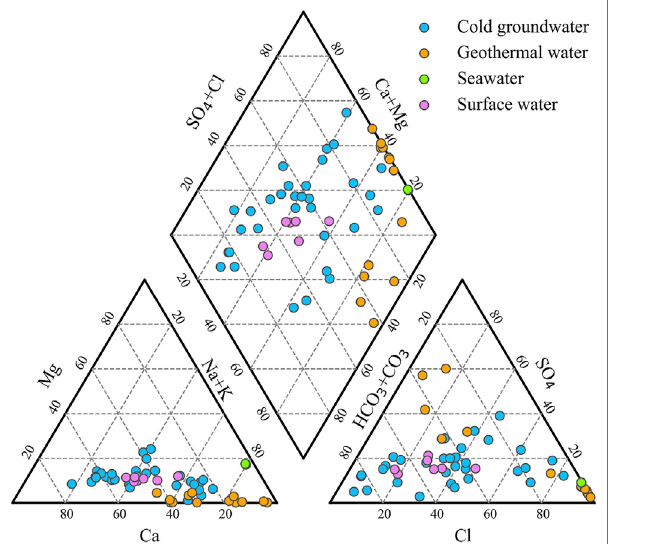
FIGURE 2 | Piper trilinear diagram of water samples from Xiamen.